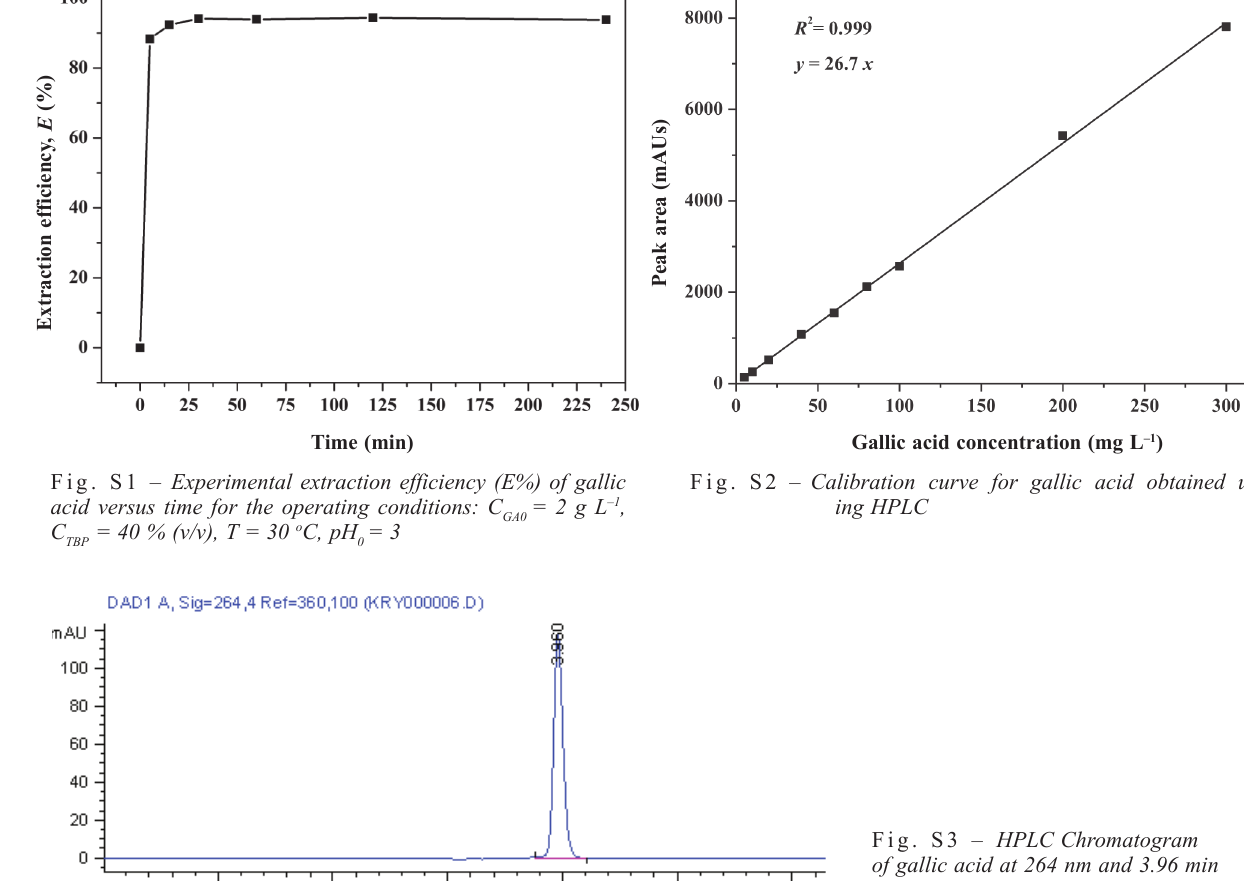
Fig. S3 – HPLC Chromatogram of gallic acid at 264 nm and 3.96